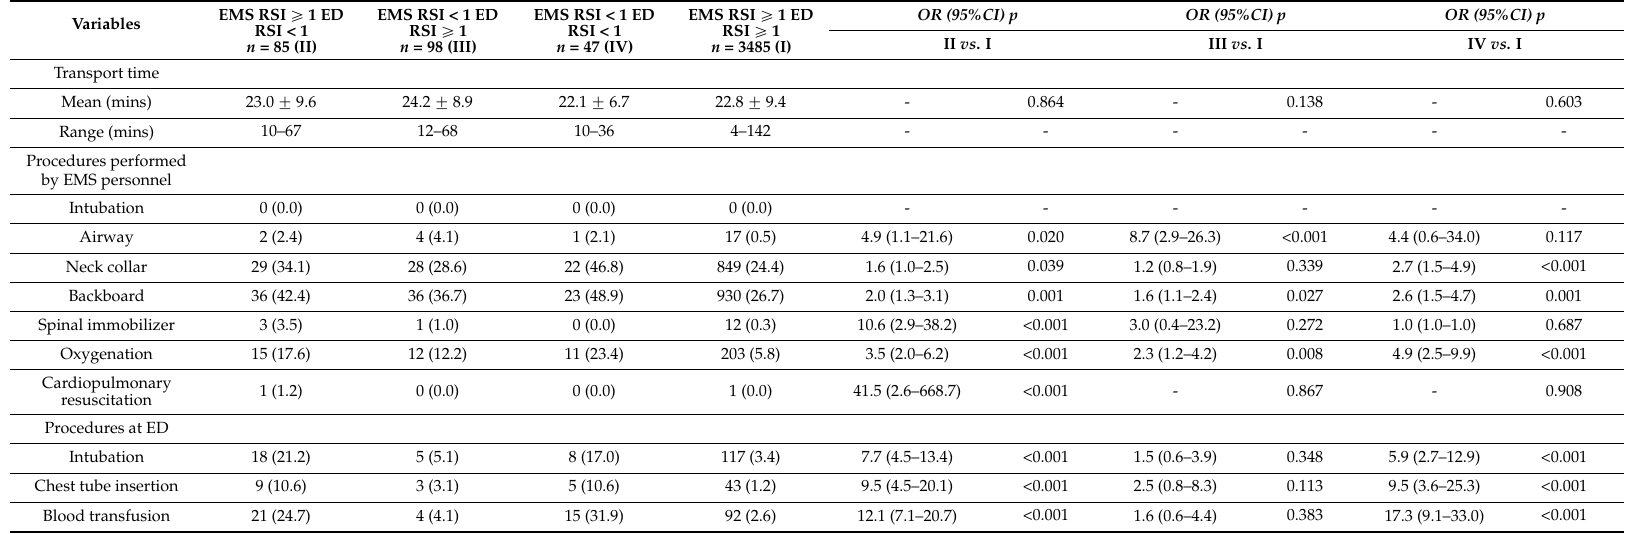
Table 2. Transport time and procedures performed by EMS and ED